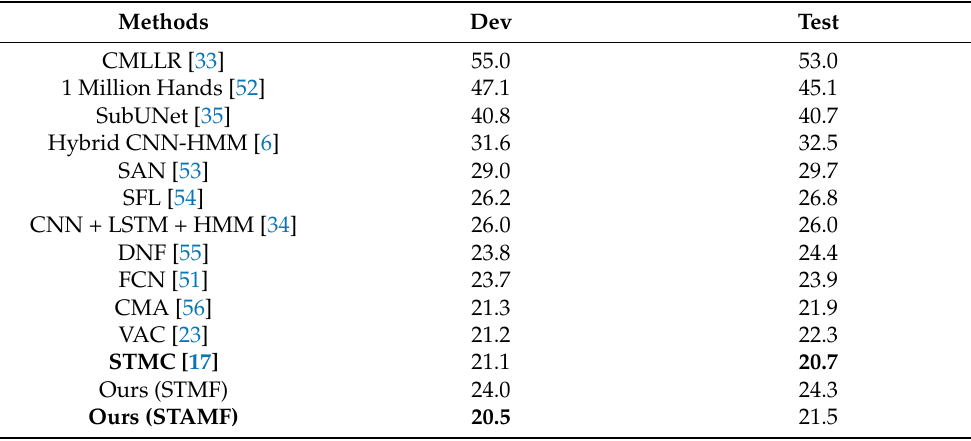
Table 6. WER Performance comparison on the RWTH-PHOENIX